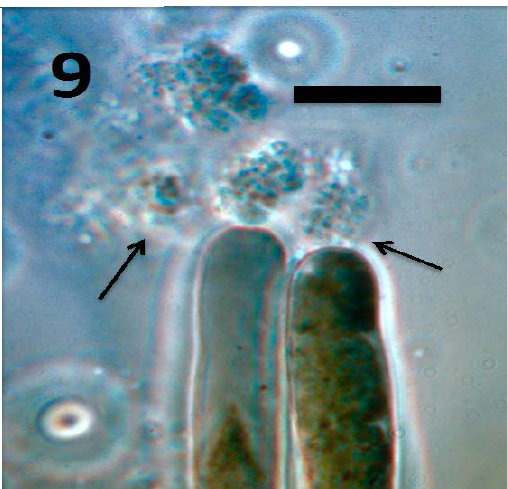
Figure 9. Root hairs of tomato seedling showing emergence of tetrads of M. luteus (arrows) from hair tips (bar = 20 µm; stained with 3,3-diaminobenzidine followed by aniline blue).